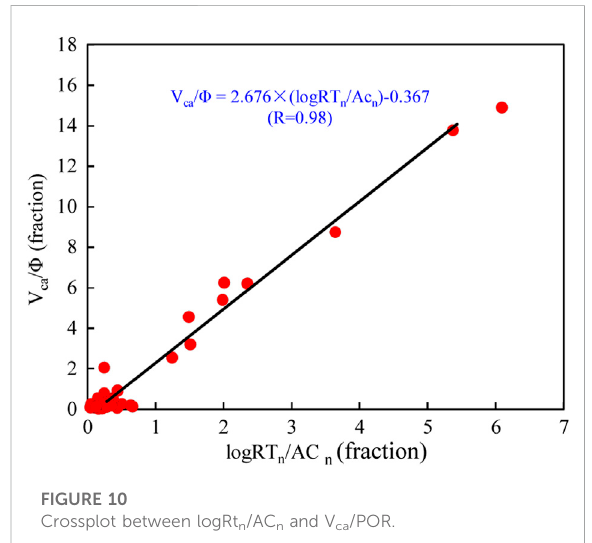
FIGURE 10 Crossplot between logRt n /AC n and V ca /POR.